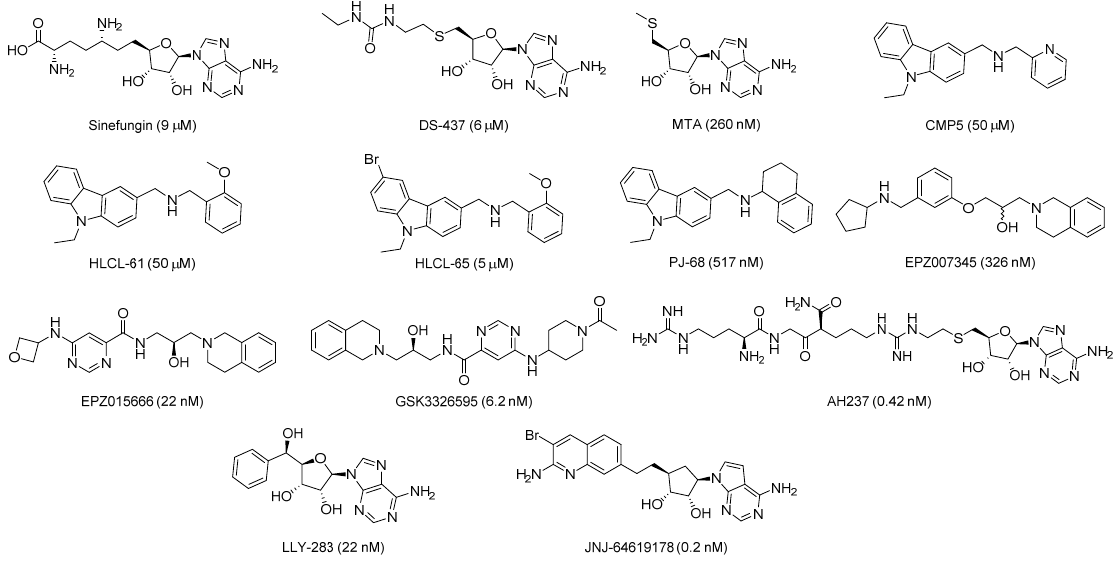
Figure 1. Representative structures of the reported inhibitors of PRMT5. Both JNJ ‐ 64619178 (a SAM ‐ competitive inhibitor) and GSK3326595 (a substrate ‐ competitive inhibitor) are in phase I clinical tri ‐ competitive inhibitor) and GSK3326595 (a substrate-competitive inhibitor) are in phase I clinical als. The third clinical trial molecule: PF ‐ 06939999, does not have a structure reported.